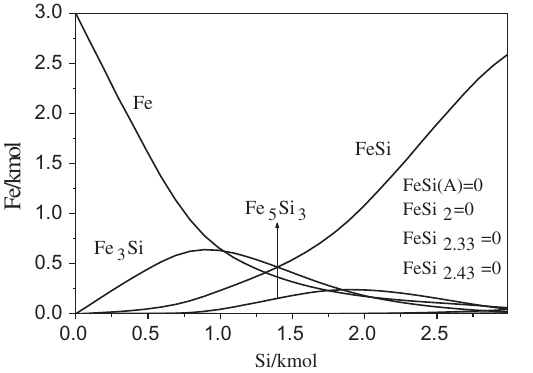
Figure 13: The balance of Fe – Si system, for Si contents up to 3